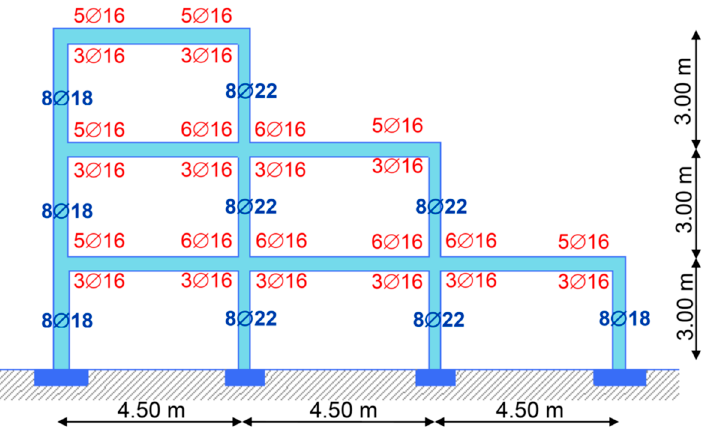
Figure 3. Frame B1 properties.